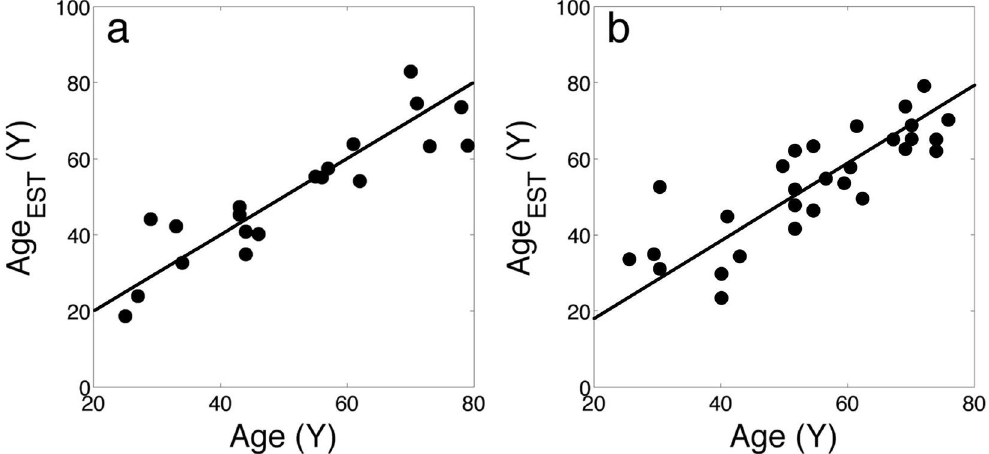
Figure 3. Plot of estimated age vs. real sample age for the Agegroup 1 (left) and the Agegroup 2 dataset (right). Pearson’s correlation coefficients in the two cases are R = 0.93 and R = 0.69, respectively.